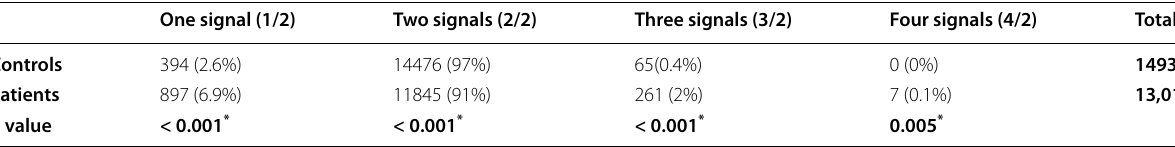
p : p value for comparing between patients and controls * Statistically significant at p ≤